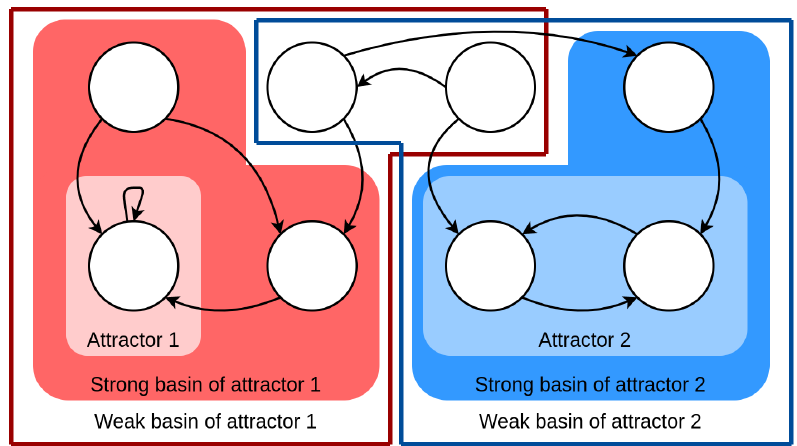
Figure 2. Attractors, weak basins and strong basins in an STG of BN. The BN contains two attractors: single-state attractor 1 (light-red area) and cyclic two-states attractor 2 (light-blue area). Both these attractors have strong basins of size 3 (solid red area for attractor 1, blue are for attractor 2 resp.). Please note that states of attractors are also parts of their basins. Moreover, the strong basins never have any intersections as given by definition. Finally, the red-lined and blue-lined areas contain weak basin states of attractor 1 and attractor 2. The strong basin is always a subset of a weak basin. The weak basins are